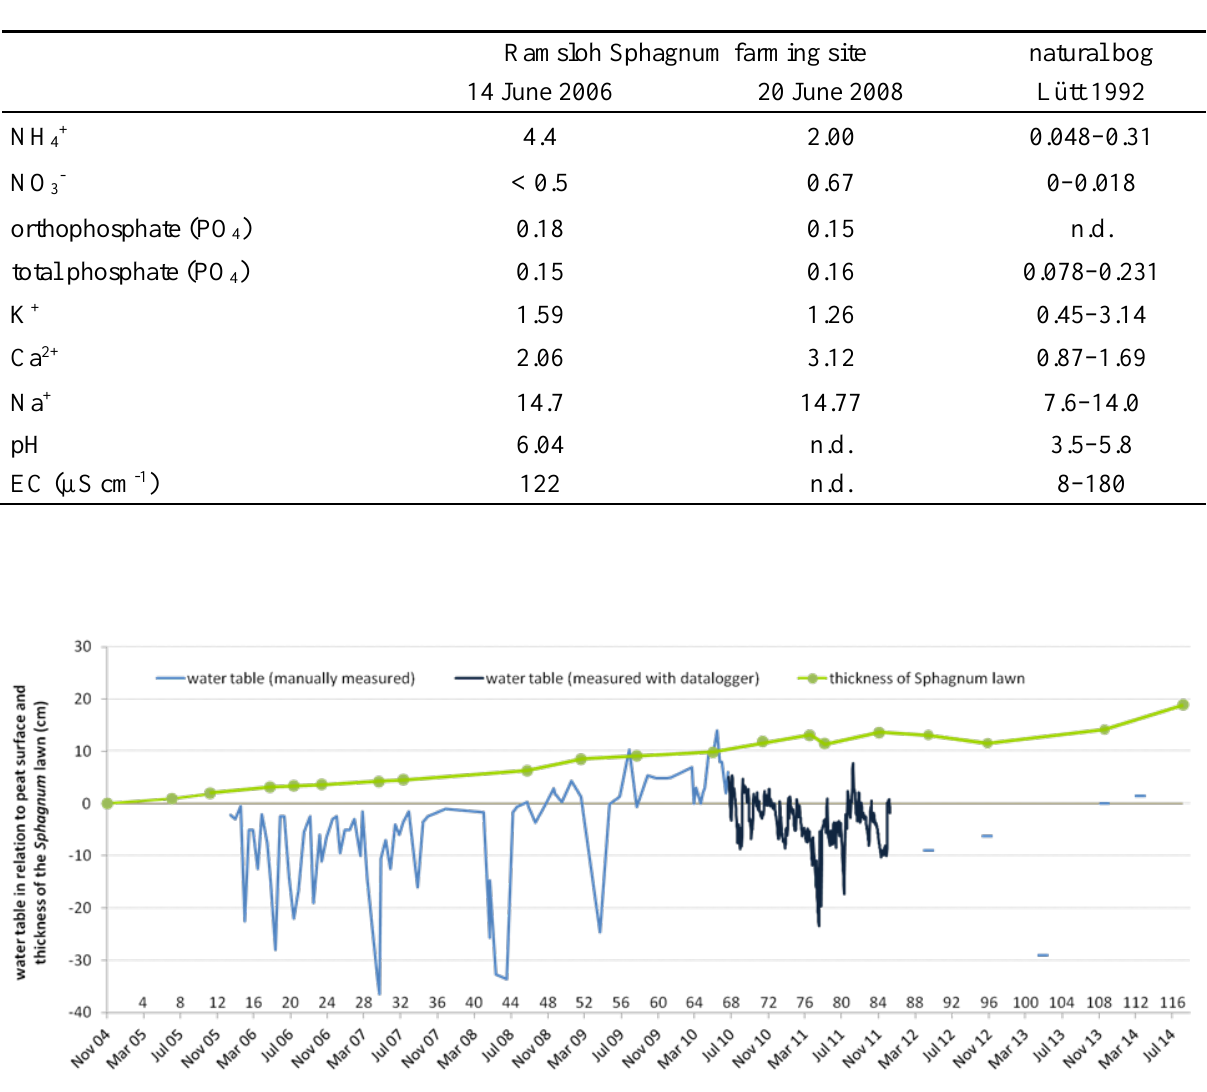
Table 2. Comparison of irrigation water quality at the study site in June 2006 (after Kamermann & Blankenburg 2008) and June 2008 ( n = 1) with the characteristics of pore water in a natural bog (Lütt 1992). n.d. = data not determined. Unless otherwise indicated, units are mg L -1 .